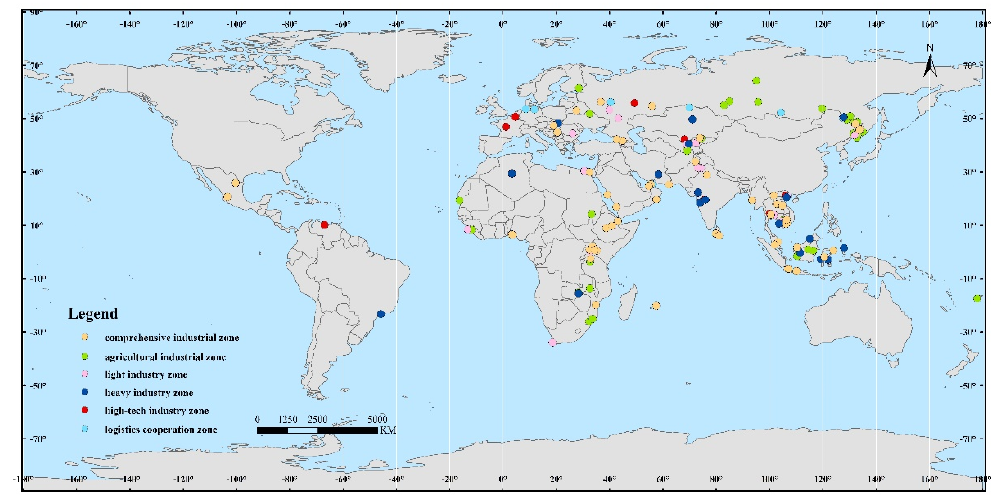
Figure 3. The types of OETCZs.